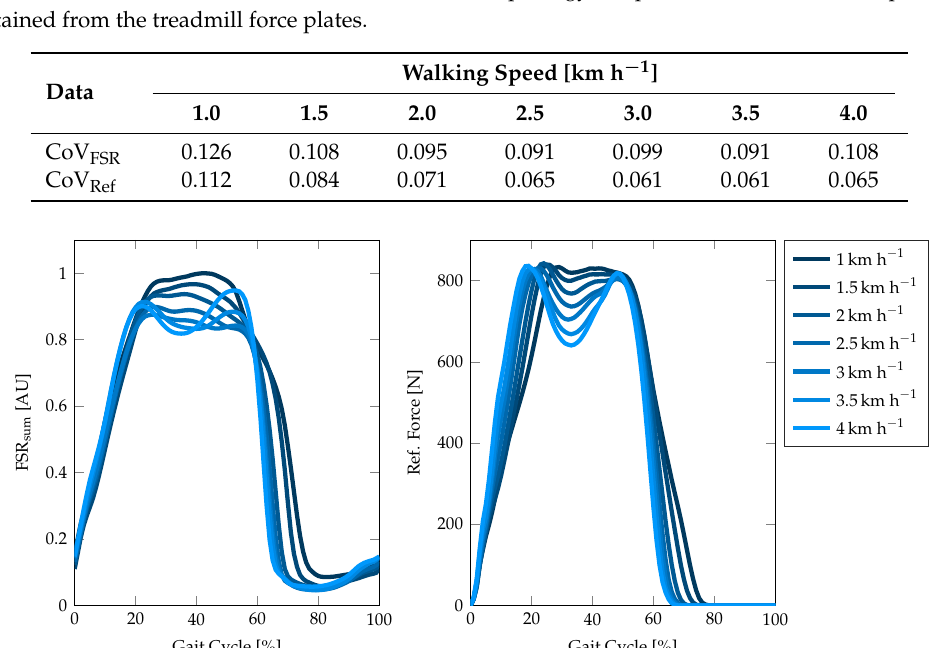
Table 5. Coefficient of variation [] for the mean FSR morphology compared to the reference morphology obtained from the treadmill force plates.